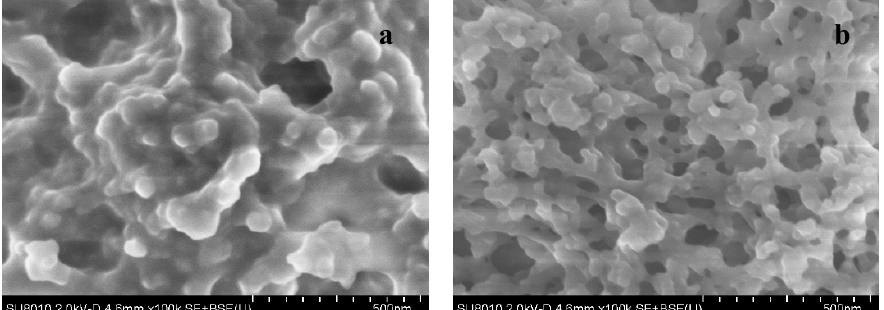
Figure 3. Scanning electron microscopic images of an imprinted film modified electrode before ( a ) and after ( b ) removing AFP.